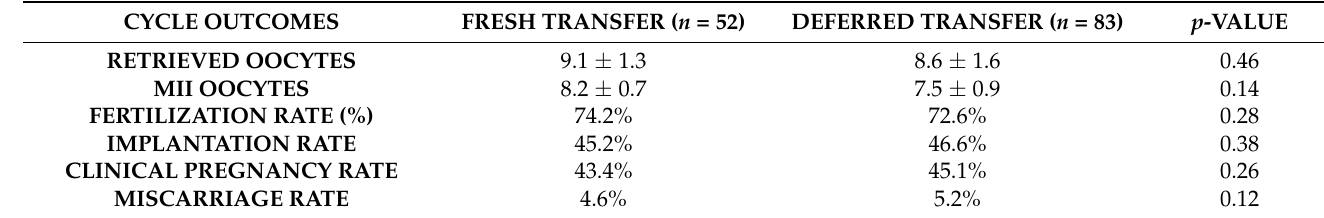
Table 4. IVF-ICSI Outcomes in PGT-A